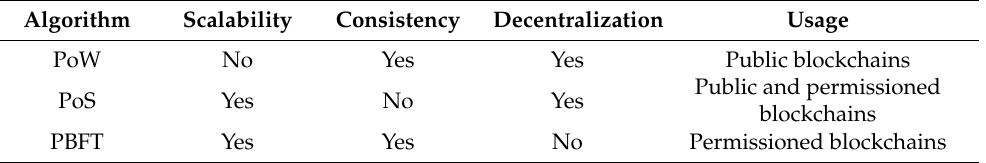
Table 1. Comparison between consensus algorithms and their common